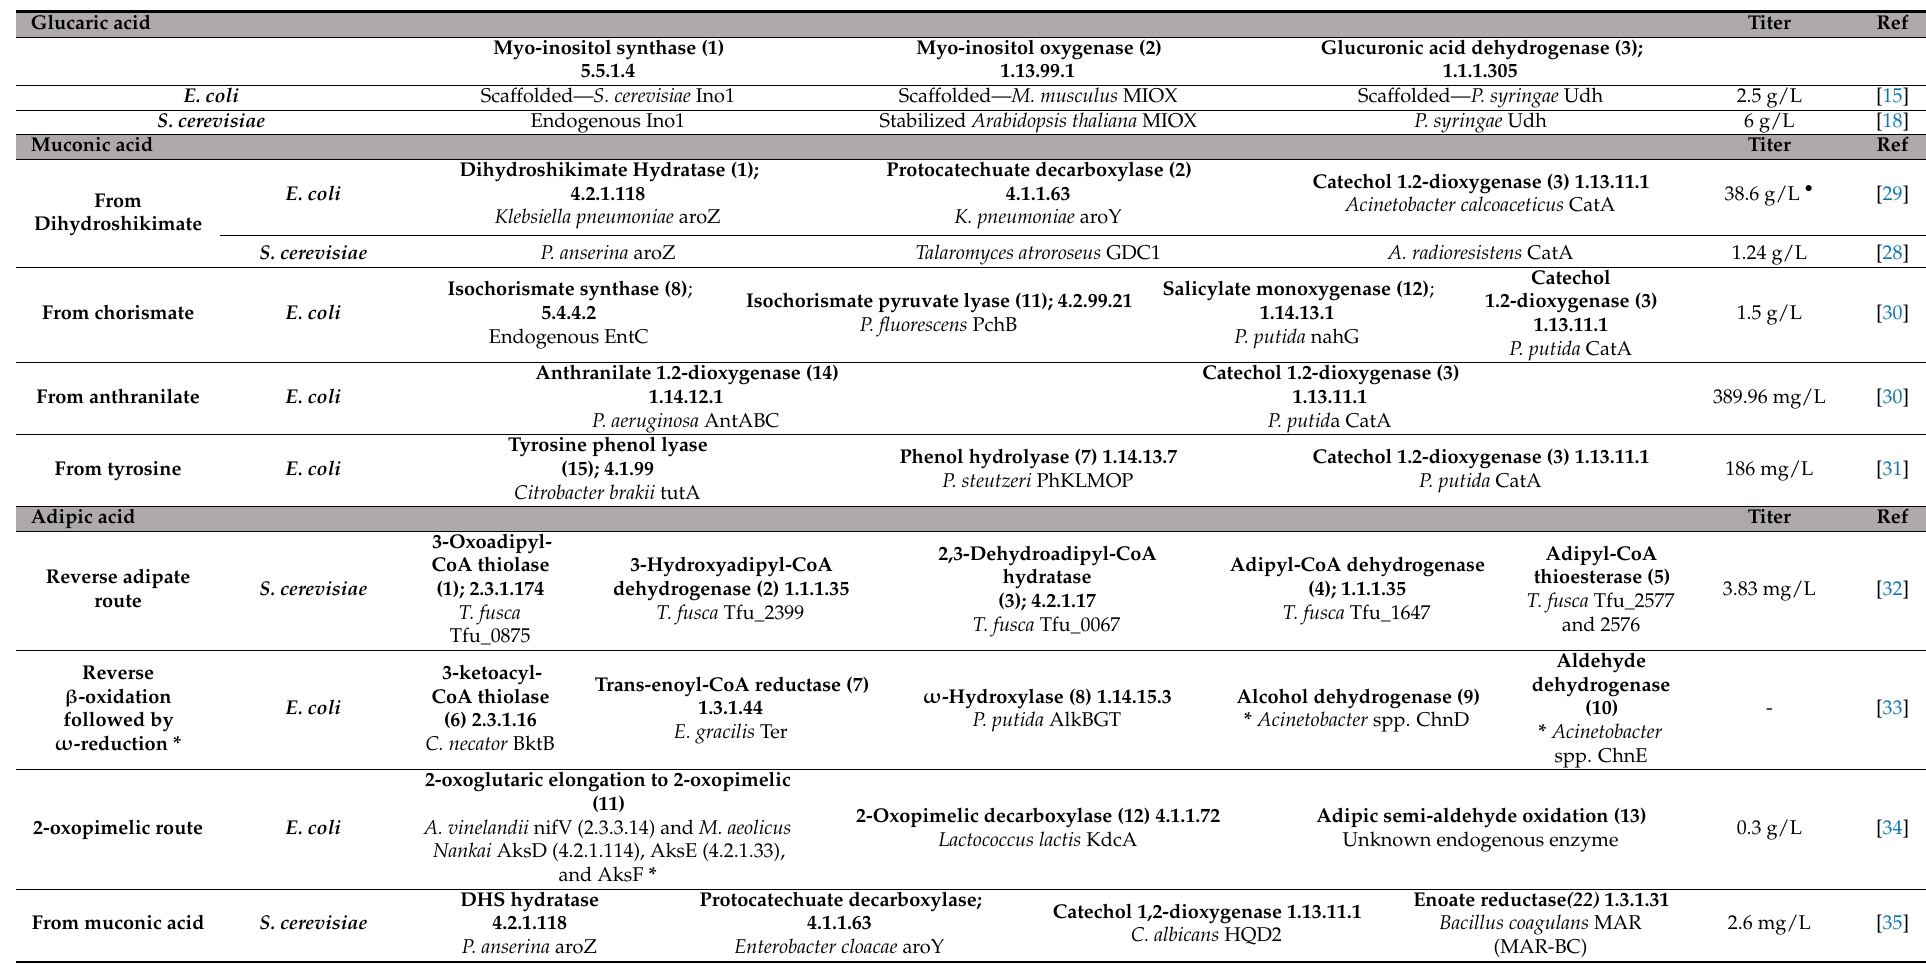
Table 2. Examples of enzyme combinations that have been successfully assembled to enable production of glucaric, muconic, adipic, acrylic and levulinic acids in E. coli or S. cerevisiae. The data shown here is further complemented in Supplementary Table S1, where it shows the comprehensive list of enzyme combinations published thus far in the assembly of synthetic pathways for the production of the above referred CAs. The numbers in brackets assigned to each non-native enzyme correspond to the steps of the synthetic pathway shown in Figure 2 and Figures 4–6. It is also indicated for each enzyme the corresponding EC